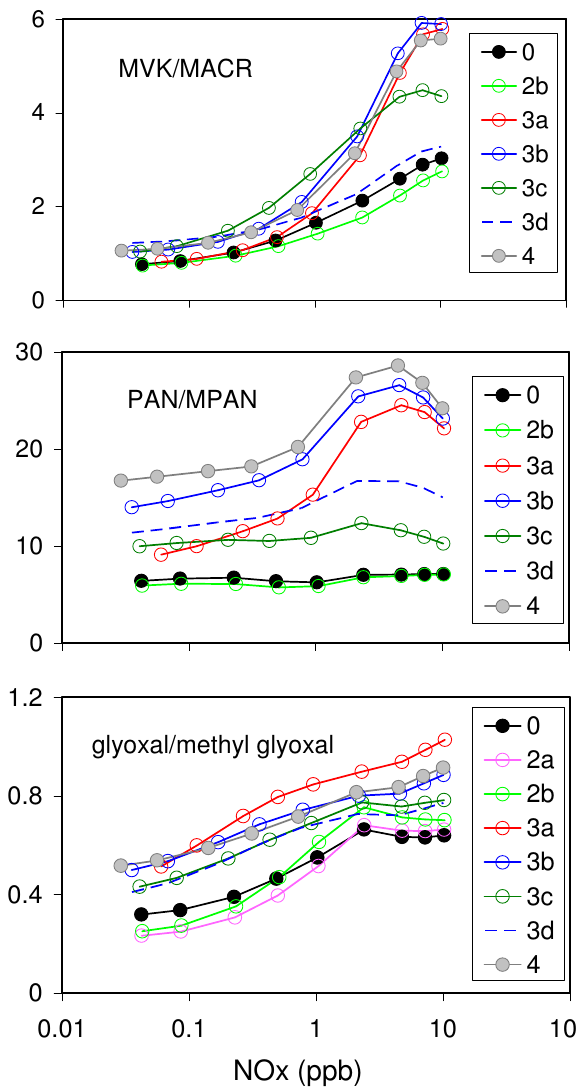
Fig. 9. Simulated product ratios for selected products of isoprene oxidation as a function of NO x mixing ratio, using MCM v3.1 (Mechanism 0) and the mechanism variants described in Table 1. All values are daytime averages over the second day of the sim- ulations, calculated from 06:00 to 18:00 local time in the model. Results for Mechanism 1 and Mechanism 2a (where not shown) are indistinguishable from Mechanism